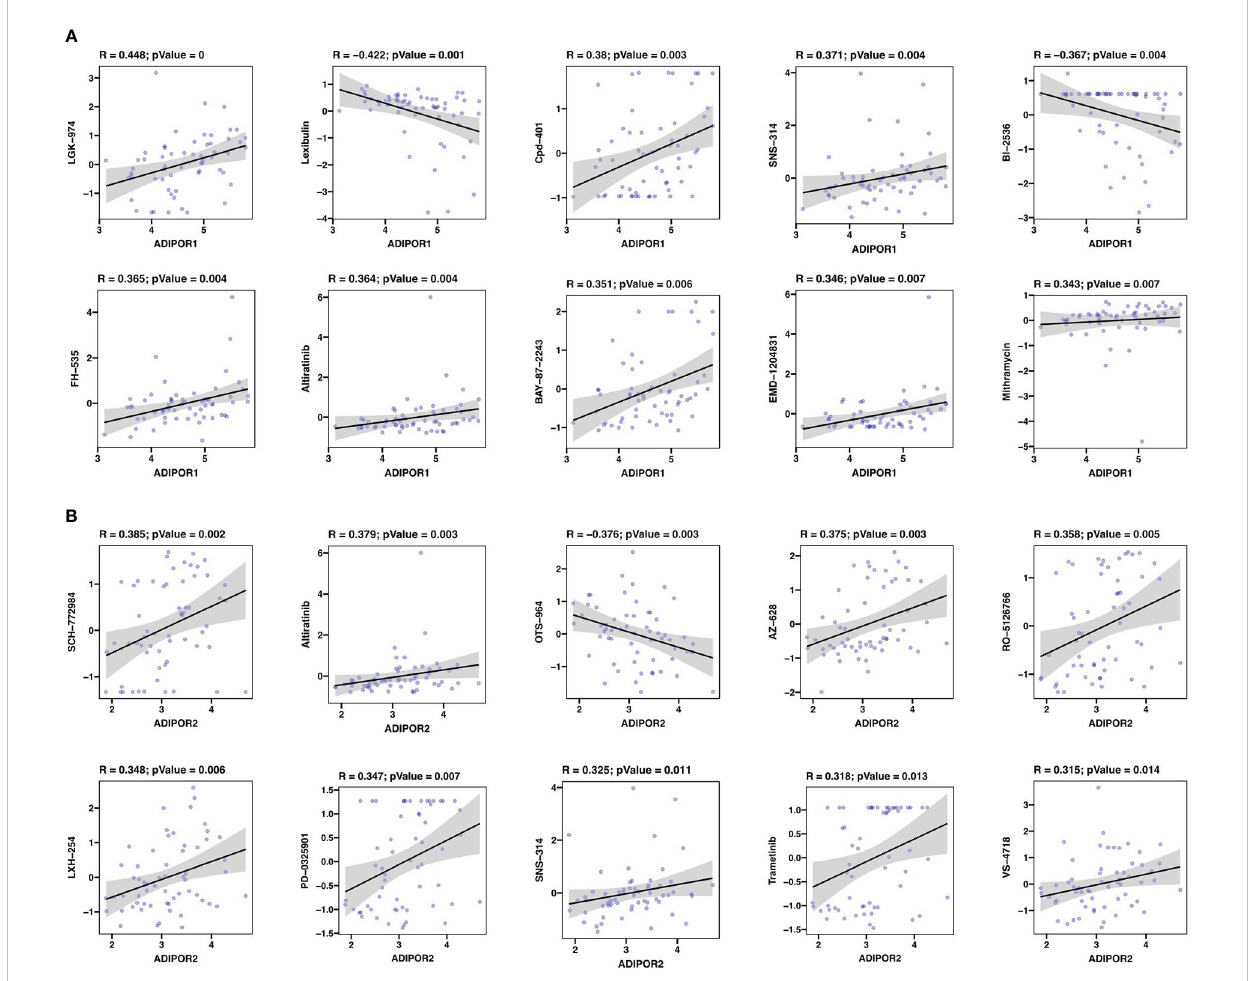
FIGURE 10 Drug sensitivity analysis. (A) The correlation between ADIPOR1 and drug sensitivity. (B) The correlation between ADIPOR2 and drug